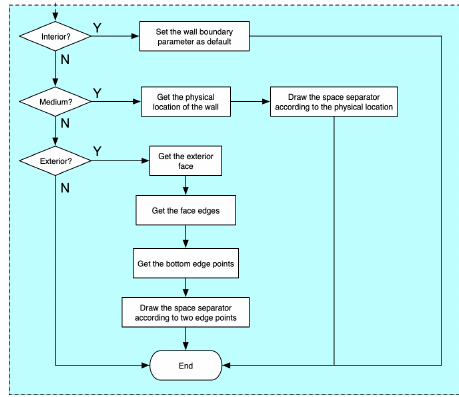
Figure 6. Creating a different type of boundary